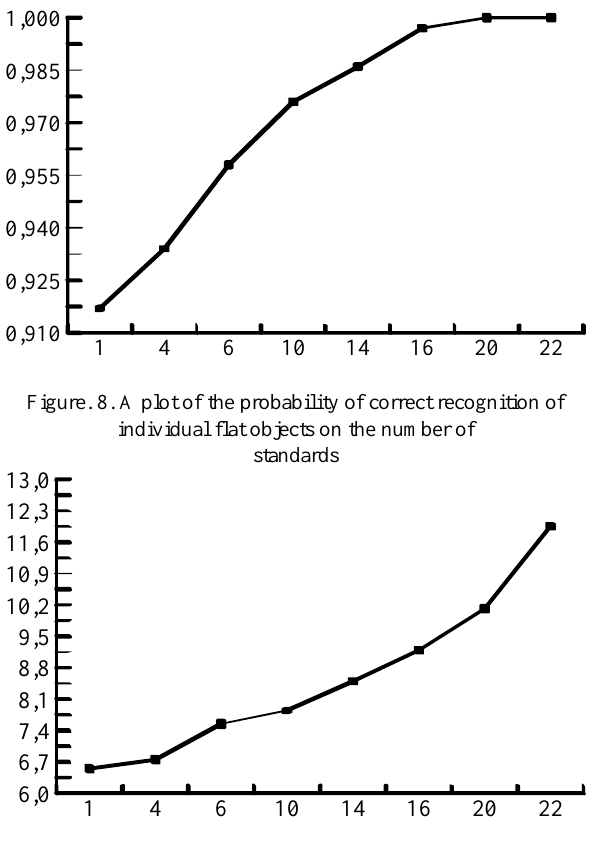
Figure. 9. Schedule time change detection of individual flat objects on the number of standards